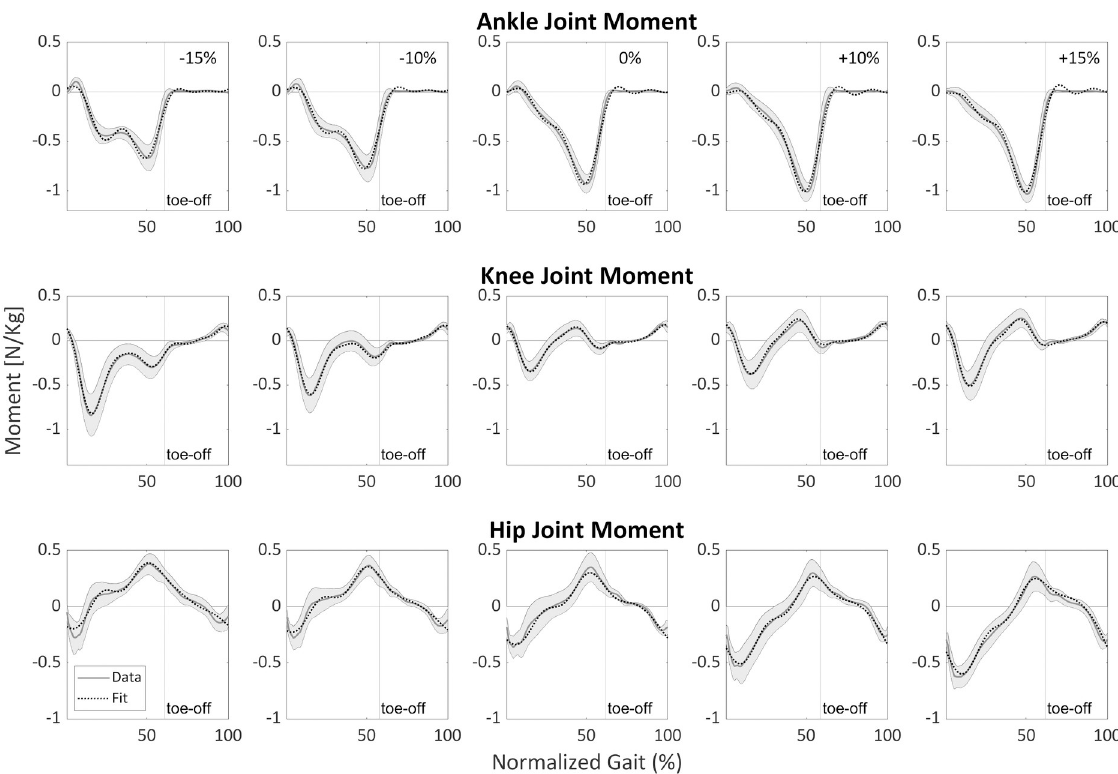
Fig 5. Sagittal plane lower-limb joint moments’ final fits for walking at 1.25 m/s as a function of surface gradient (-15%, -10%, 0%, +10%, +15%) and stride cycle percentage (0% is heel strike) compared with experimental data. The dotted line represents fit, and the gray line represents average data across all participants. The gray shading is the between-participants variability represented with one standard deviation. The moments are normalized by the participants’ height and mass.